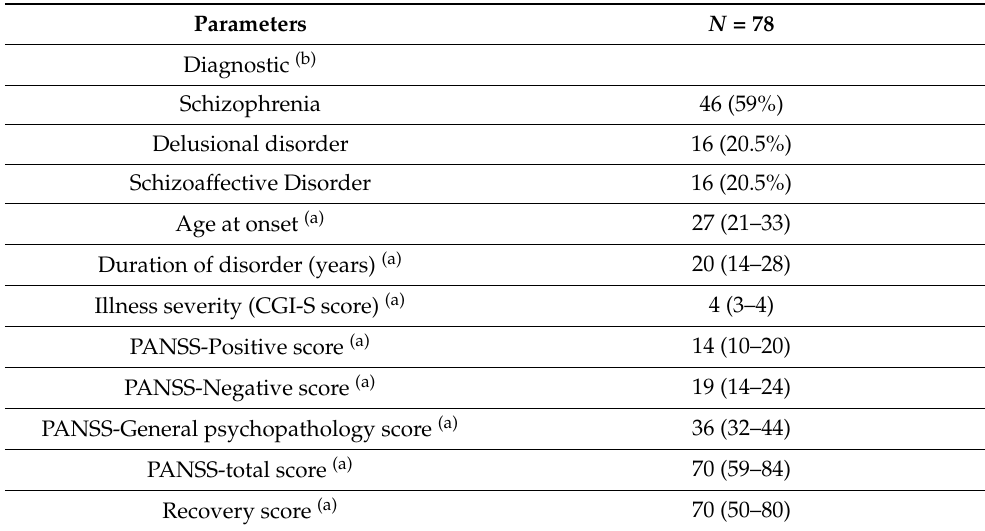
Table 2. Clinical characteristics of the